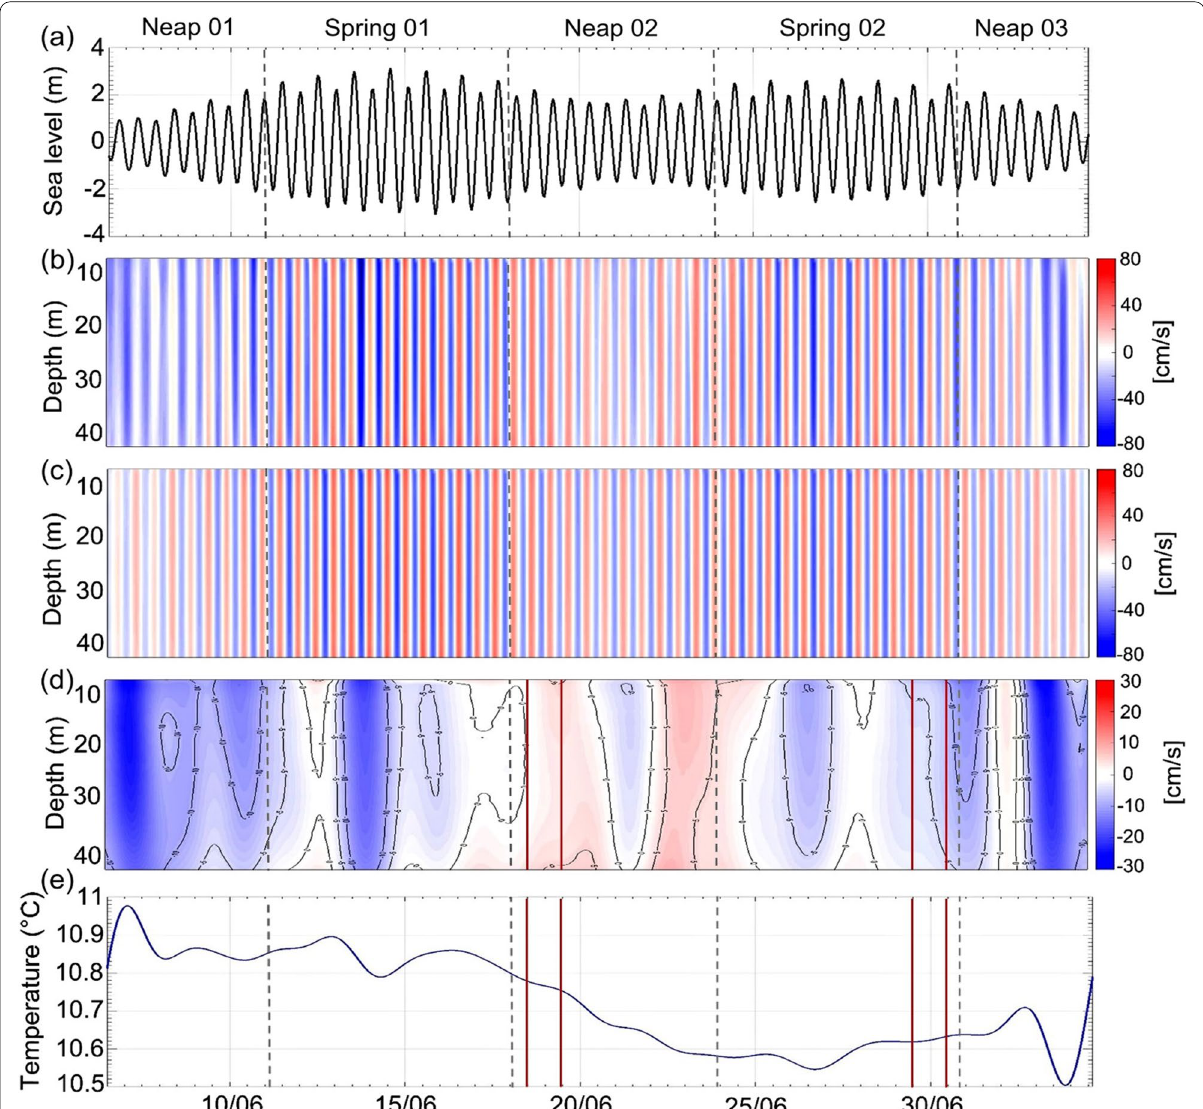
Fig. 9 a Sea level anomaly, b Along‑channel component of the total current, c Along‑channel tidal current, d Along‑channel subtidal current, e Bottom temperature coming from ADCP. Red vertical lines show the zooplankton‑CTDO (June 19) and CTDO (June 30) sampling